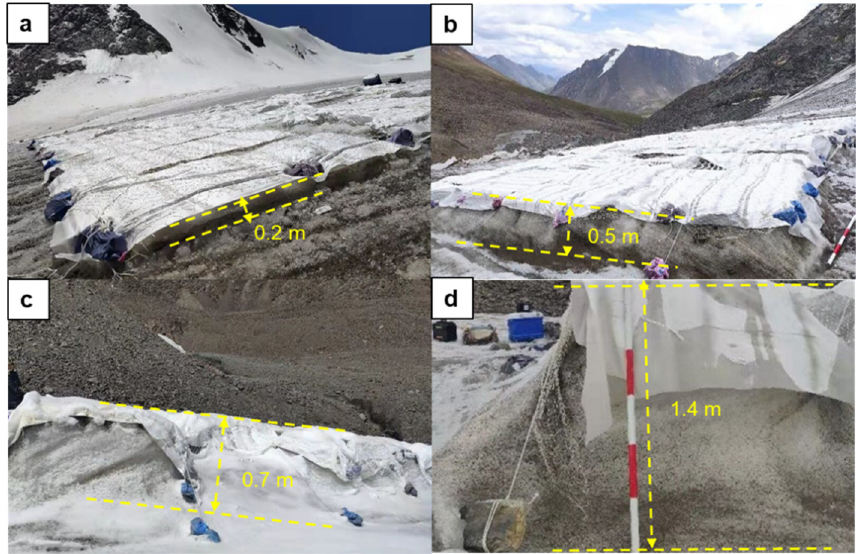
Figure 4. Effectiveness of the nanofiber material on UG1: 1 July ( a ), 9 July ( b ), 25 July ( c ), and 15 August ( d ).